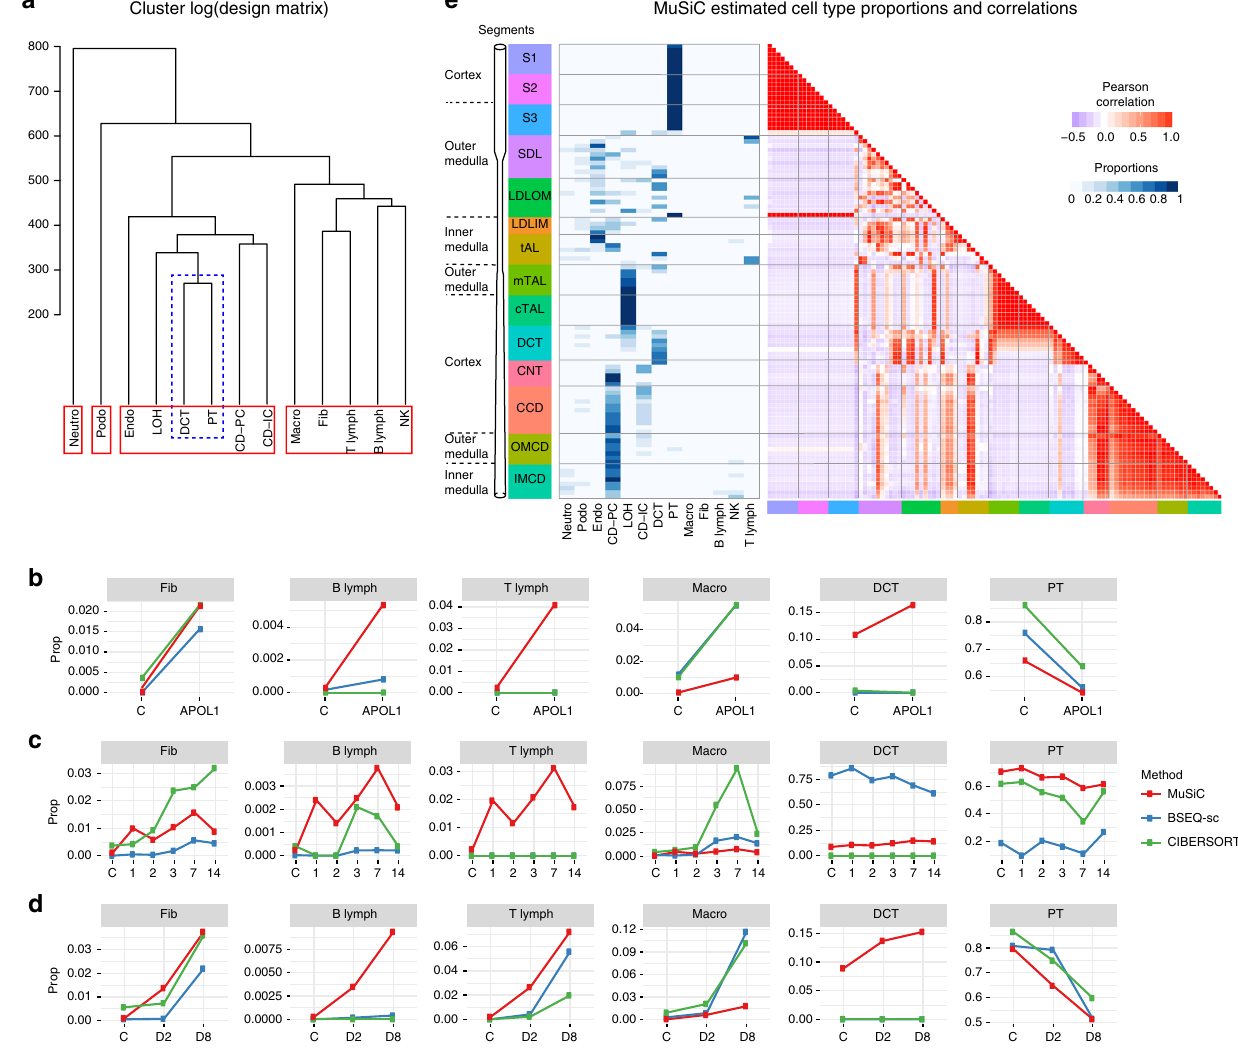
Fig. 3 Cell type composition in kidney of mouse CKD models and rat. a Cluster dendrogram showing similarity between 13 cell types that were con fi dently characterized in Park et al. Abbreviations: Neutro: neutrophils, Podo: podocytes, Endo: endothelials, LOH: loop of Henle, DCT: distal convolved tubule, PT: proximal tubule, CD-PT: collecting duct principal cell, CD-IC: CD intercalated cell, Macro: macrophages, Fib: fi broblasts, NK: natural killers. b – d Average estimated proportions for 6 cell types in bulk RNA-seq samples taken from three different studies, each study based on a different mouse model for chronic kidney disease. Results from three different deconvolution methods (MuSiC, BSEQ-sc and CIBERSORT) are shown by different colors. Supplementary Figure 5a – c show complete estimation results of all 13 cell types. b Bulk samples are from Beckerman et al., who sequenced 6 control and 4 APOL1 mice. c Bulk data are from Craciun et al. 9 , where samples are taken before (C) and at 1, 2, 3, 7, 14 days after administering folic acid. Line plot shows cell type proportion changes over time (days), averaged over 3 replicates at each time point. d Bulk data are from Arvaniti et al. 10 , where samples are taken from mice after Sham operation (C), 2 days after UUO operation (D2), and 8 days after UUO operation (D8). The average proportions at each time point are plotted. e MuSiC estimated cell type proportions of rat renal tubule segments. The estimated cell type proportions (left) and the proportions correlations between samples (right) are shown as heatmap. Segment names are color coded and aligned according to their physical positions along the renal tubule. Supplementary Figure 6a – c show NNLS, BSEQ-sc and CIBERSORT results. Segment name abbreviation: S1 S1 proximal tubule, S2 S2 proximal tubule, S3 S3 proximal tubule, SDL short descending limb, LDLOM long descending limb, outer medulla, LDLIM long descending limb, inner medulla, tAL thin ascending limb, mTAL medullary thick ascending limb, cTAL cortical thick ascending limb, DCT distal convoluted tubule, CNT connecting tubule, CCD cortical collecting duct, OMCD outer medullary collecting duct, IMCD inner medullar collecting duct. Source data are provided as a Source Data fi